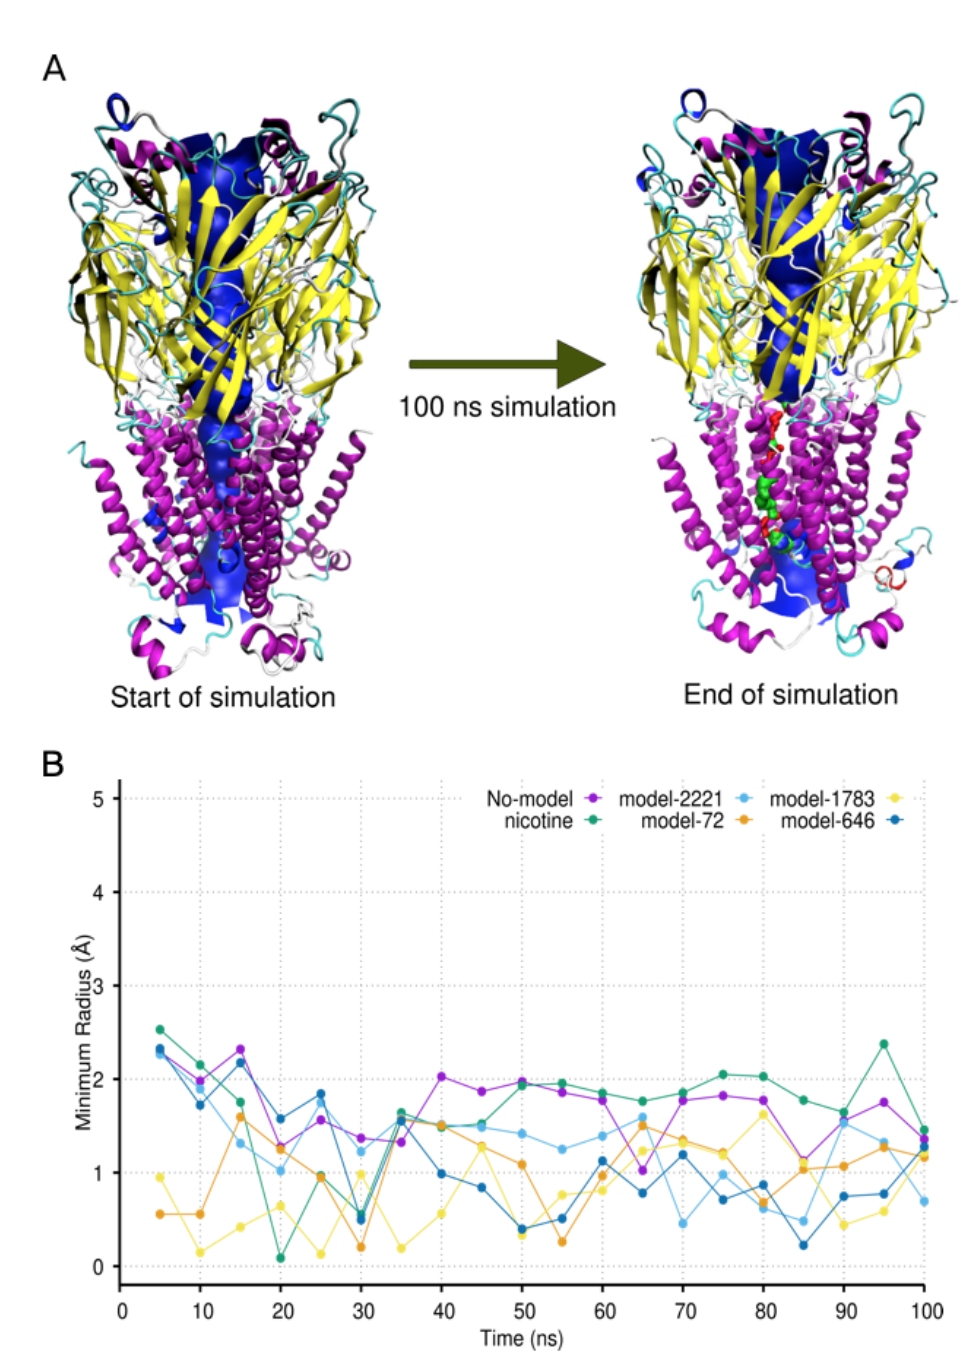
Figure 8. Dynamics of receptor ion channel during simulation. ( A ) Changes in the pore size of the ion channel in the nAChR in complex with model-1783. The pore of the channel is shown in blue, red, or green. Blue denotes an instance where the radius of the pore was large enough for water molecules and cations to pass through. Red denotes where the pore radius was too small for ions and water molecules to pass through the pore. Green denotes a pore radius size sufficient for a single water molecule to pass. ( B ) Fluctuations of the minimum pore radius of the ion channel during the simulation